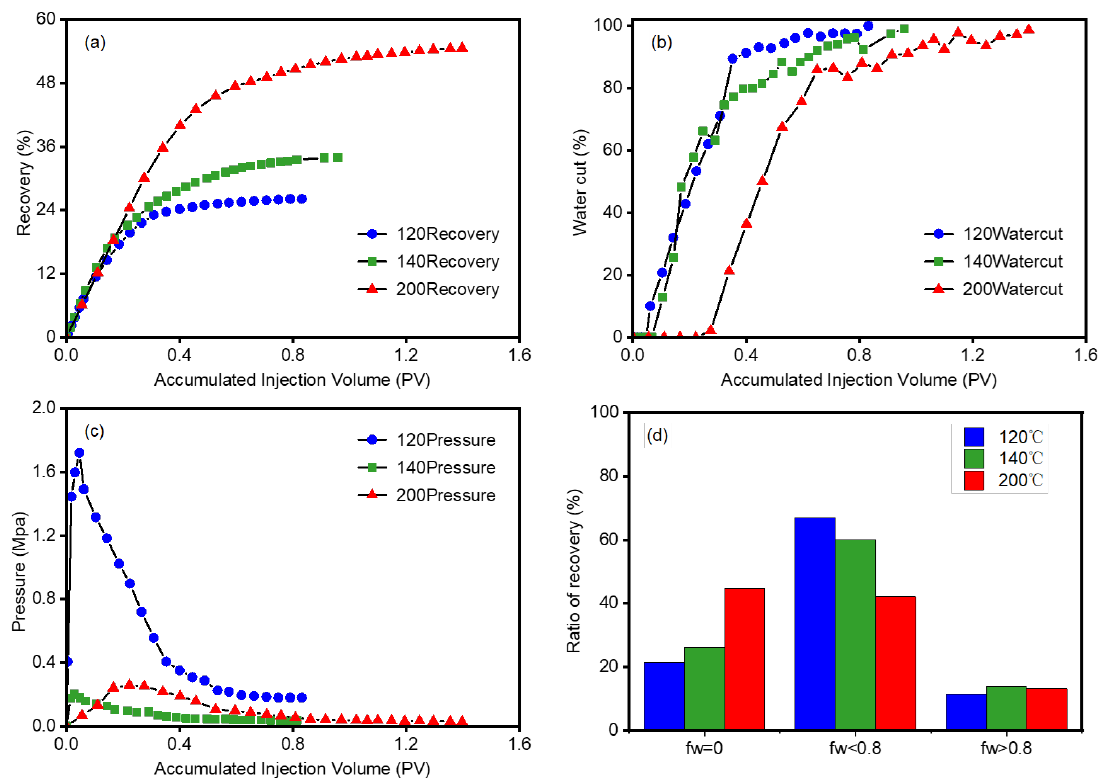
Figure 2. Production dynamic curve of steam flooding heavy oil at different temperatures. ( a ) Re- covery, ( b ) water cut, ( c ) pressure, ( d ) ratio of recovery.